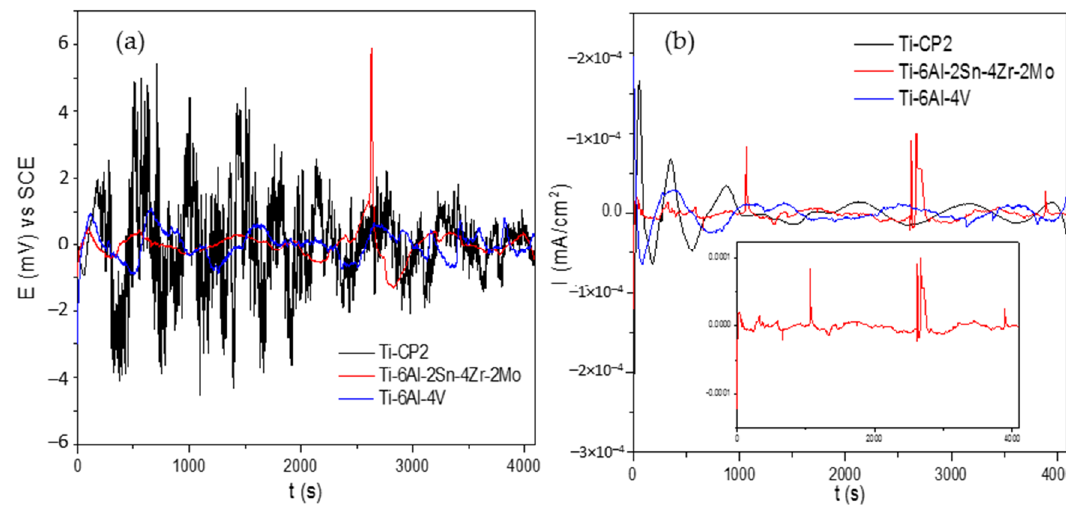
Figure 2. Time series electrochemical noise (EN) data: ( a ) electrochemical potential noise (EPN) and ( b ) electrochemical current noise (ECN) in 3.5 wt. % NaCl solution.